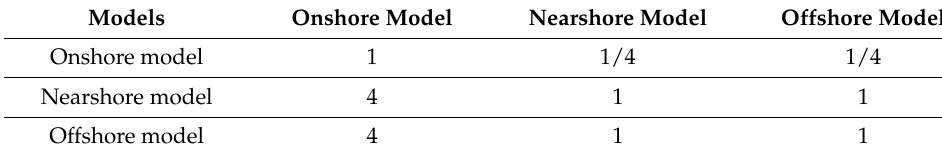
Table 8. Models preferences with respect to the criterion (employee skills).